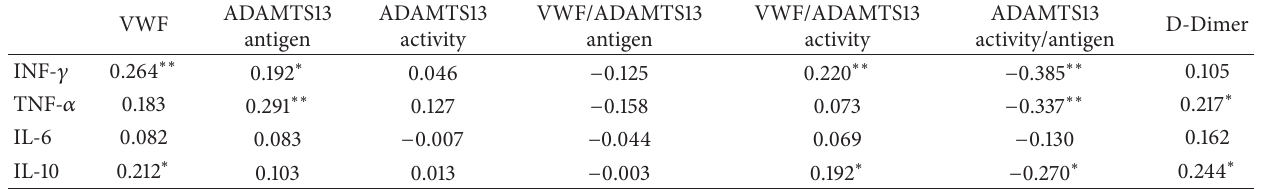
Table 3: Correlations between haemostatic and inflammatory biomarkers in type 1 diabetic patients.